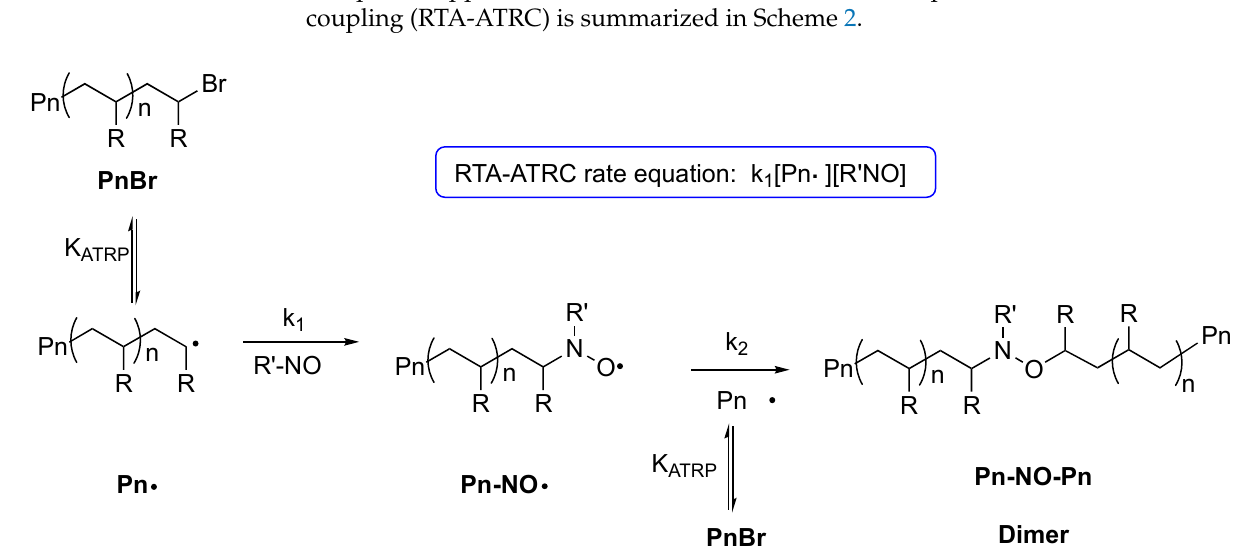
Figure 1. Summary of the challenge of finding common ATRC-type conditions across all three major classes of brominated polymers prepared by ATRP.